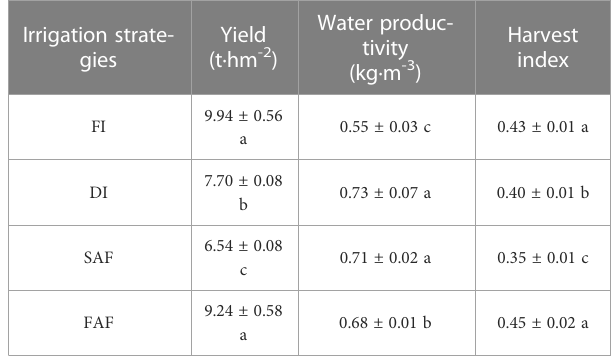
TABLE 1 Yield, harvest index (HI) and water productivity (WP) in different irrigation strategy treatments.